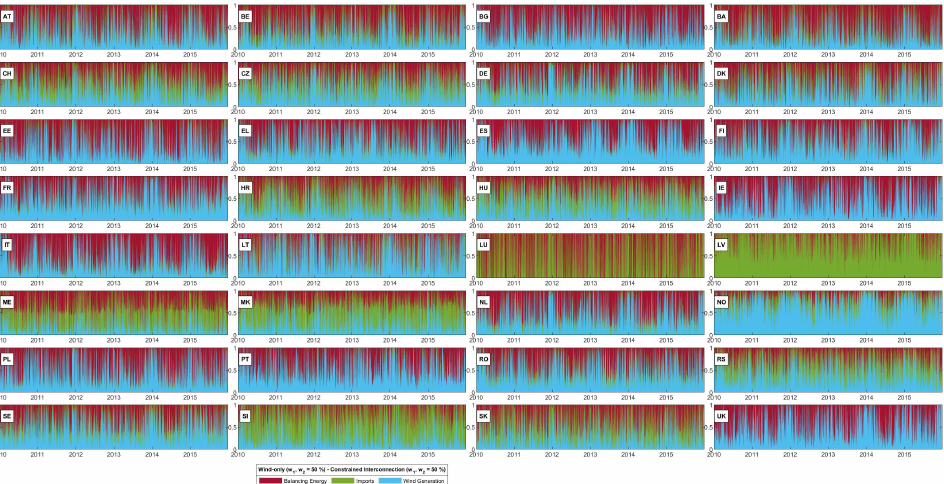
Figure 8. Left-hand side variables of the energy balance (Equation (1c)) for the case of wind power